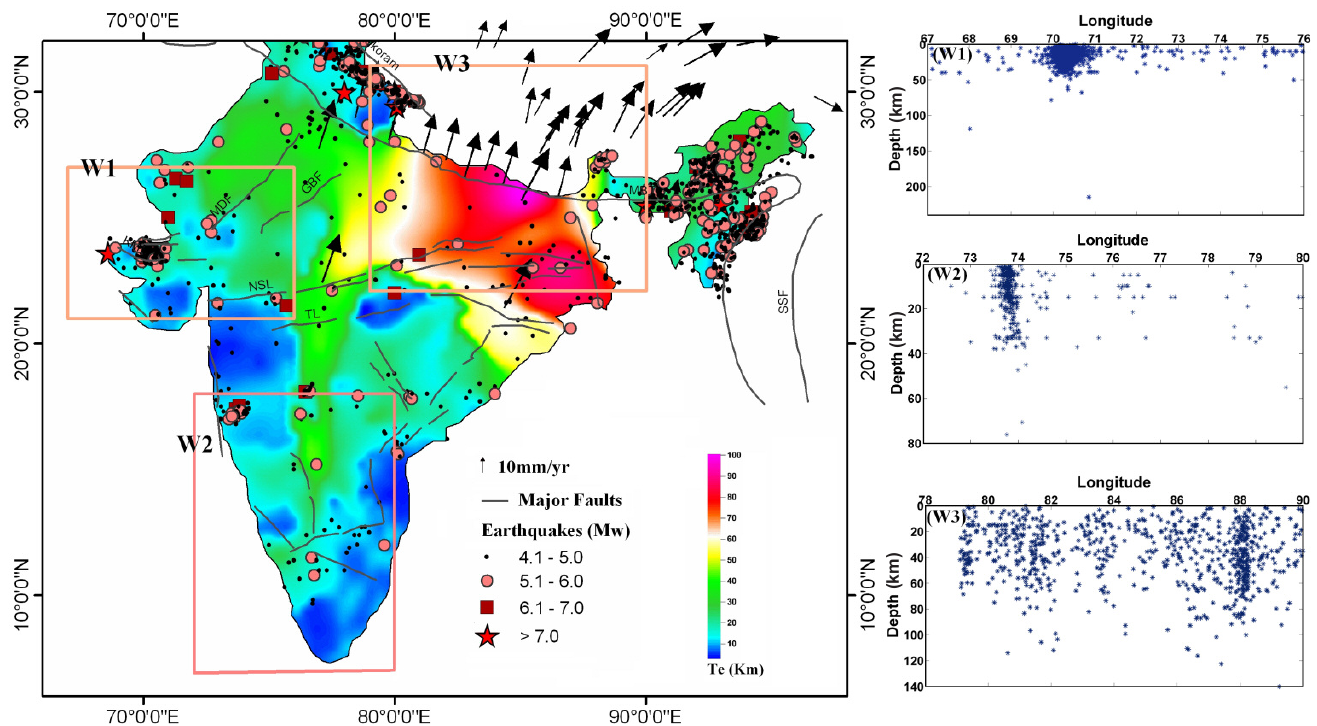
Figure 5. Spatial variation of the Te within the Indian shield shown with the tectonic features in India, with some of the major active faults and lineaments [Dasgupta et al. 2000]. Abbreviations: MDF, Mahendergarh-Dehradun fault; NSL, Narmada Son lineament; TL, Tapti lineament; SSF, Shan-Shagaing fault; MBT, Main Boundary thrust; KMF, Kutch Mainland fault. Epicenters of the different earthquakes with magnitude Mw ≥ 4 are shown. Their hypocentral depths are projected onto the vertical plane as longitude versus depth for three windows (W1, W2, W3), as shown on the right-hand side. The seismicity of the region was taken from NEIC (http://earthquake.usgs.gov/regional/neic) and GCMT (http://www.globalcmt.org/). The geodetic velocity vectors for the Indian subcontinent are shown with respect to Eurasia (arrows) [Calais et al. 2006, Meade 2007, Thatcher